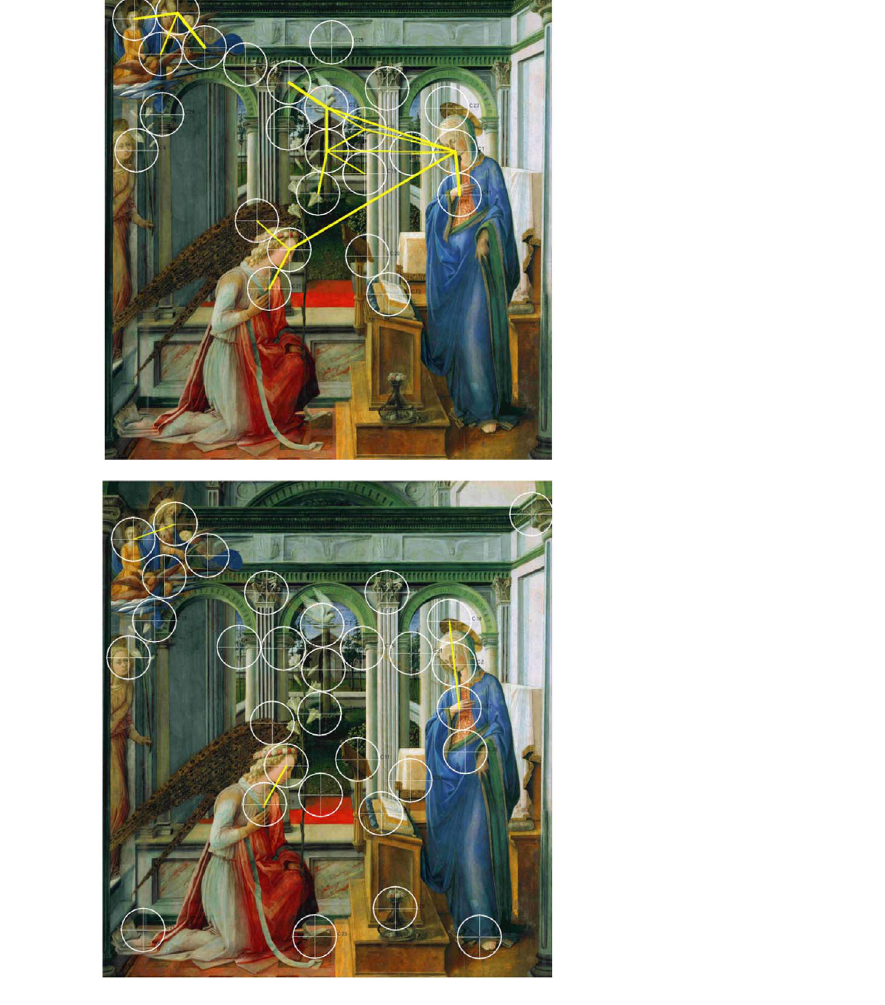
Fig. 6. Speaking effects on frequently repeated transitions between fixation clusters – Lippi. Frequently repeated transitions between fixation clusters of the experimental group during minute 11 to 15. Cluster size: 60 mm. Frequently repeated transitions between fixation clusters of the control group during minute 11 to 15. Cluster size: 60